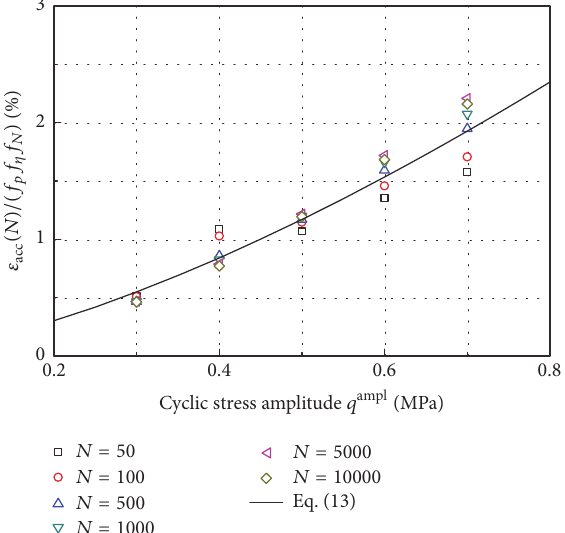
Figure 14: Normalized accumulated axial strain versus initial stress ratio.